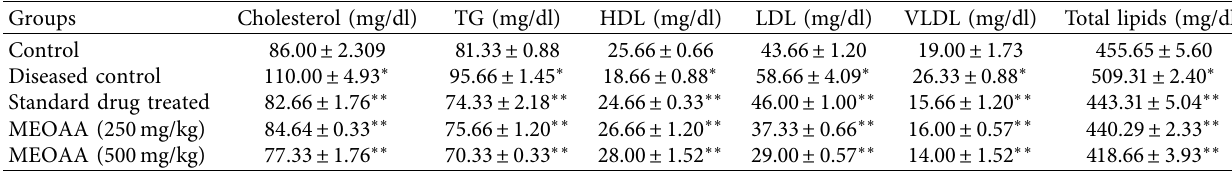
Table 5: Effect of A. arvensis on blood lipid profile.